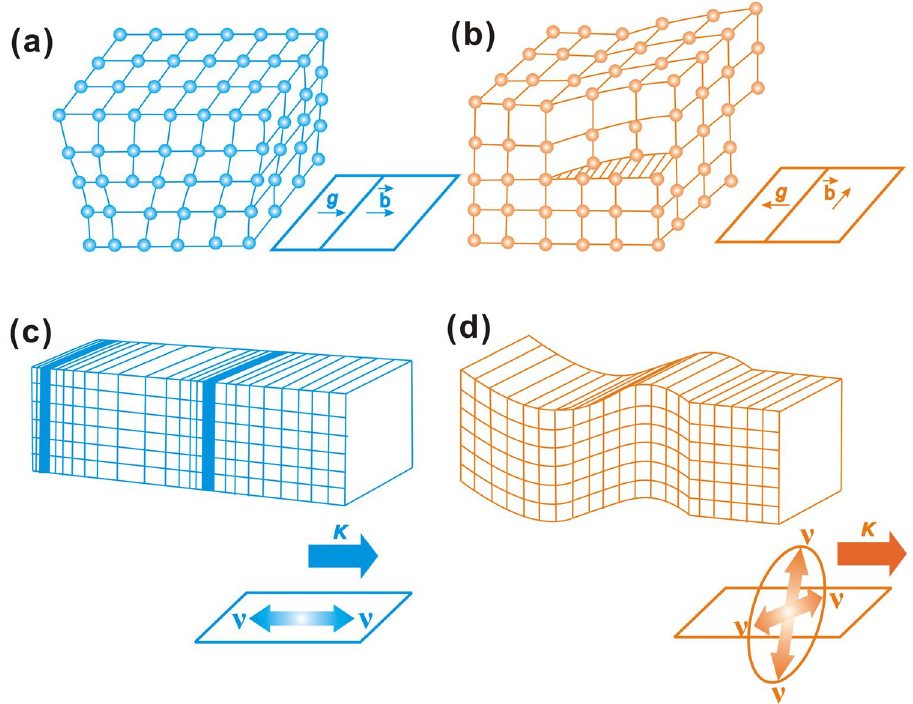
Figure 1. Crystal dislocation and wave. ( a ) edge and ( b ) screw dislocations in crystal lattices, with the arrows showing the dislocation glide direction g and Burgers vector b , respectively; ( c ) P- and ( d ) S-waves, with the propagation direction k and particle vibration direction v given by the arrows,